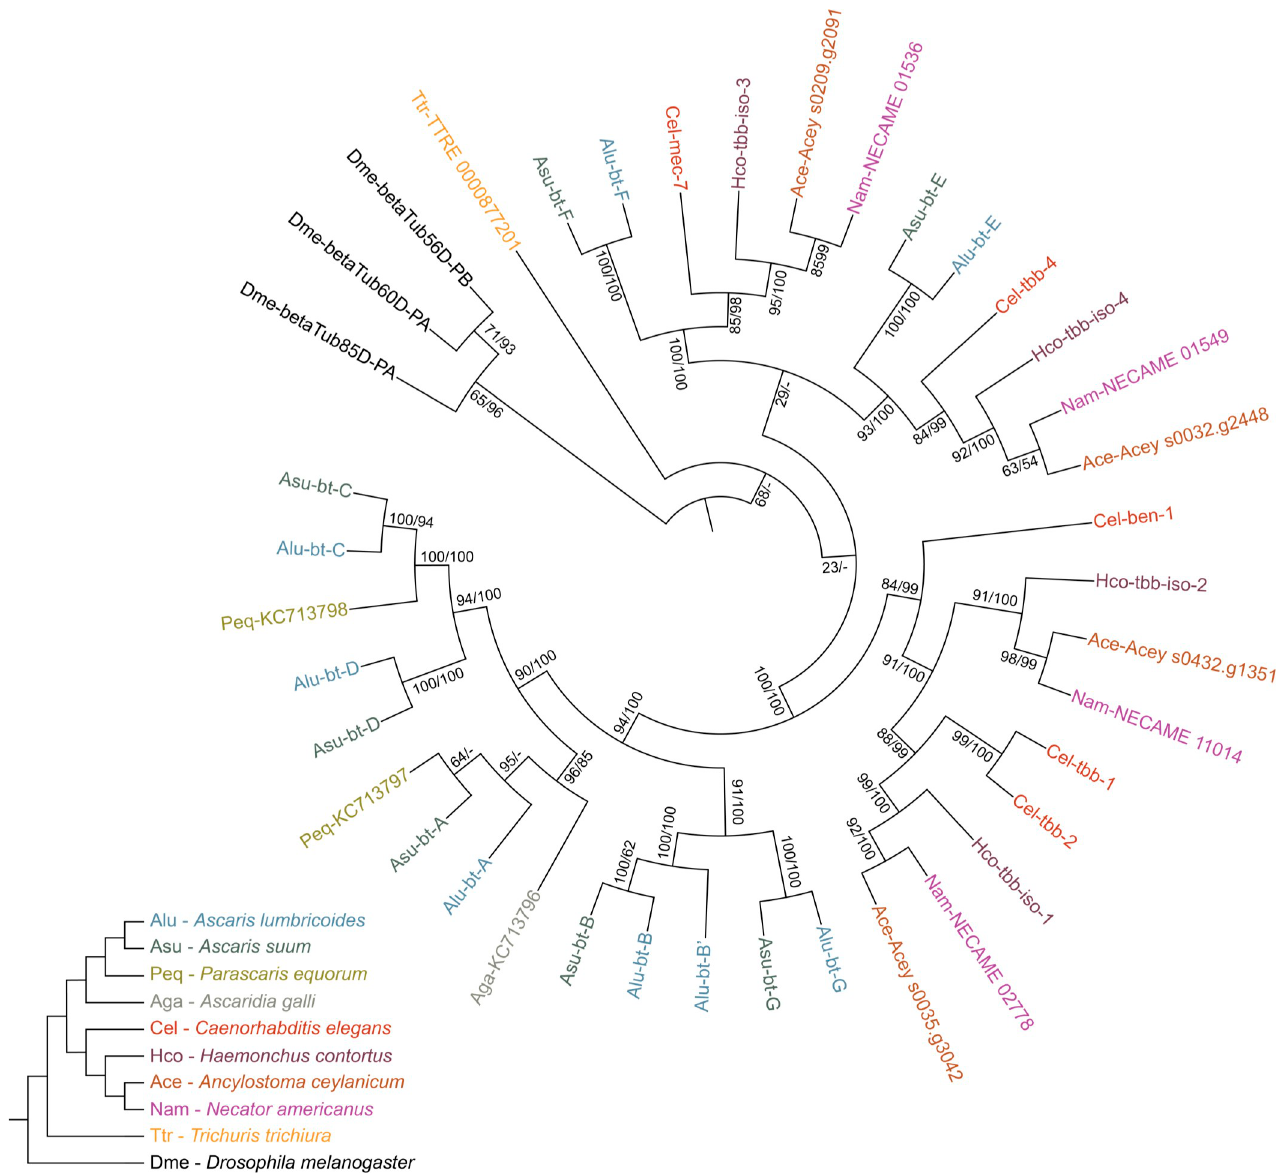
Fig 2. Phylogenetic tree of β -tubulin proteins of Ascaris species, other parasitic nematodes, and C . elegans . Phylogenies were reconstructed with RAxML and MRBAYES. The topology shown is from RaxML. The node support values are percent bootstraps / posterior probabilities. The ‘-‘ indicates that a node was not present in the MRBAYES tree. The branches are equal length to show topology clearly; a tree with branch lengths showing divergence is available in supplementary materials (S14 Info). A . ceylanicum and N . americanus (Clade V), and the free-living C . elegans (Clade V) ( S1 Info ). Both maximum likelihood and Bayesian phylogenetic trees returned similar topologies that closely followed the species phylogeny ( Fig 2 ). A . lumbricoides and A . suum have, similar to H . contortus , A . ceylanicum and N . americanus , genes that are orthologues to C . elegans mec-7 and tbb-4 (Alu/Asu-bt-E and bt-F) . The relationship to the other C . elegans genes is more complex. H . contortus , A . ceylanicum and N . americanus have two sets of clear one-to-one orthologues, but inclusion of C . elegans suggests a pattern of gene duplication and loss. Resolution of these